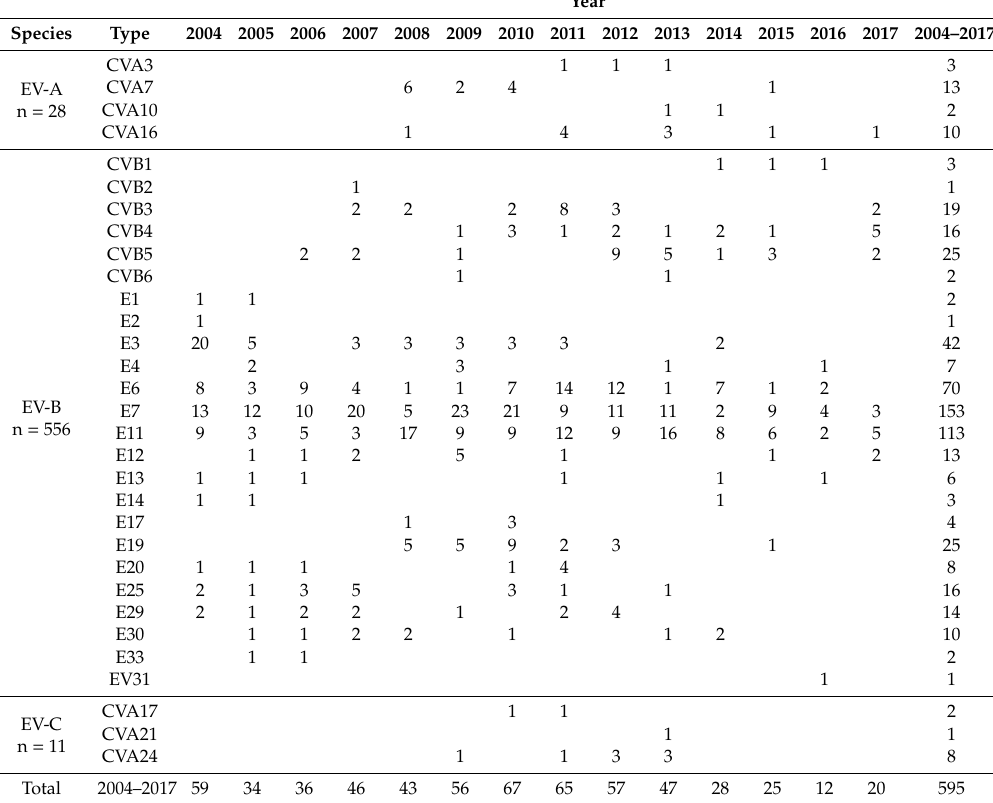
Table 2. Isolation of non-polio enteroviruses isolated from sewage, Moscow,